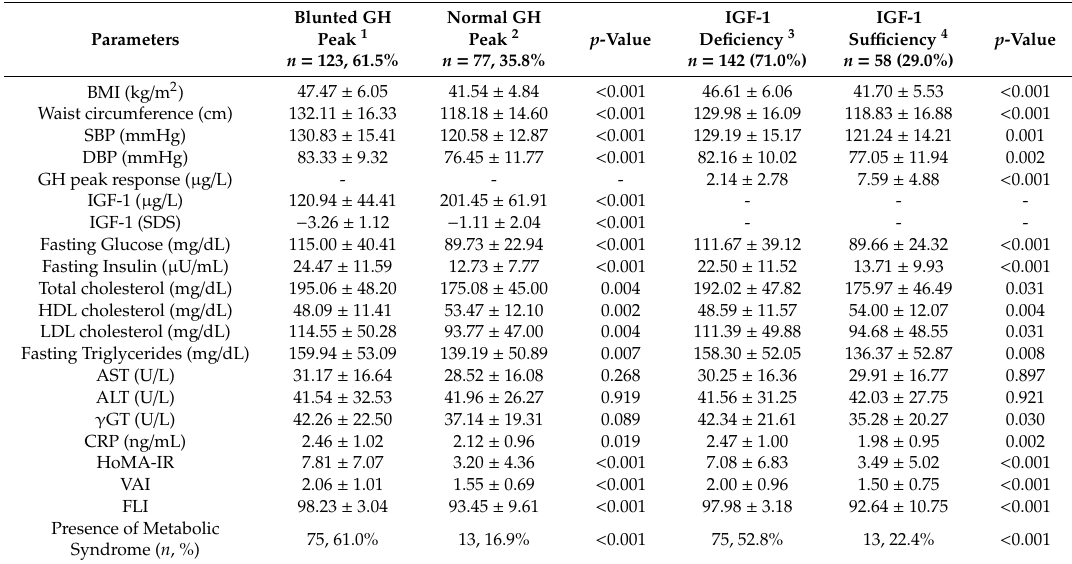
Table 2. Anthropometric measures and metabolic profile of 200 adult females with obesity according to blunted GH peak or IGF-I SDS.